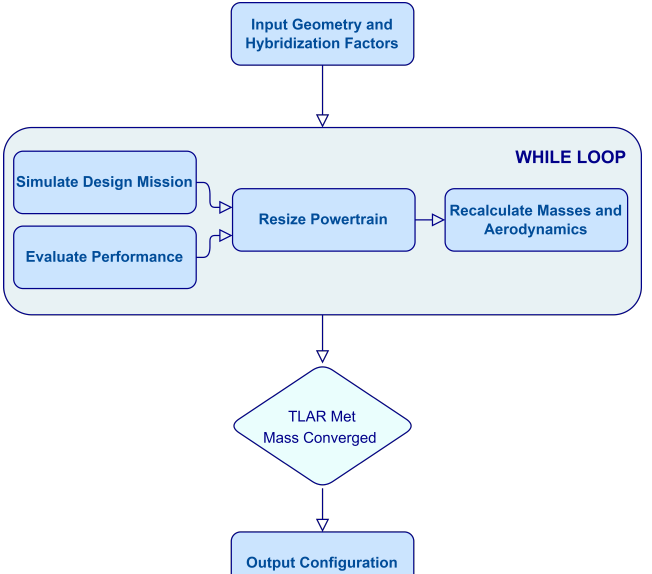
Figure 4. Simplified aircraft design workflow based on mission